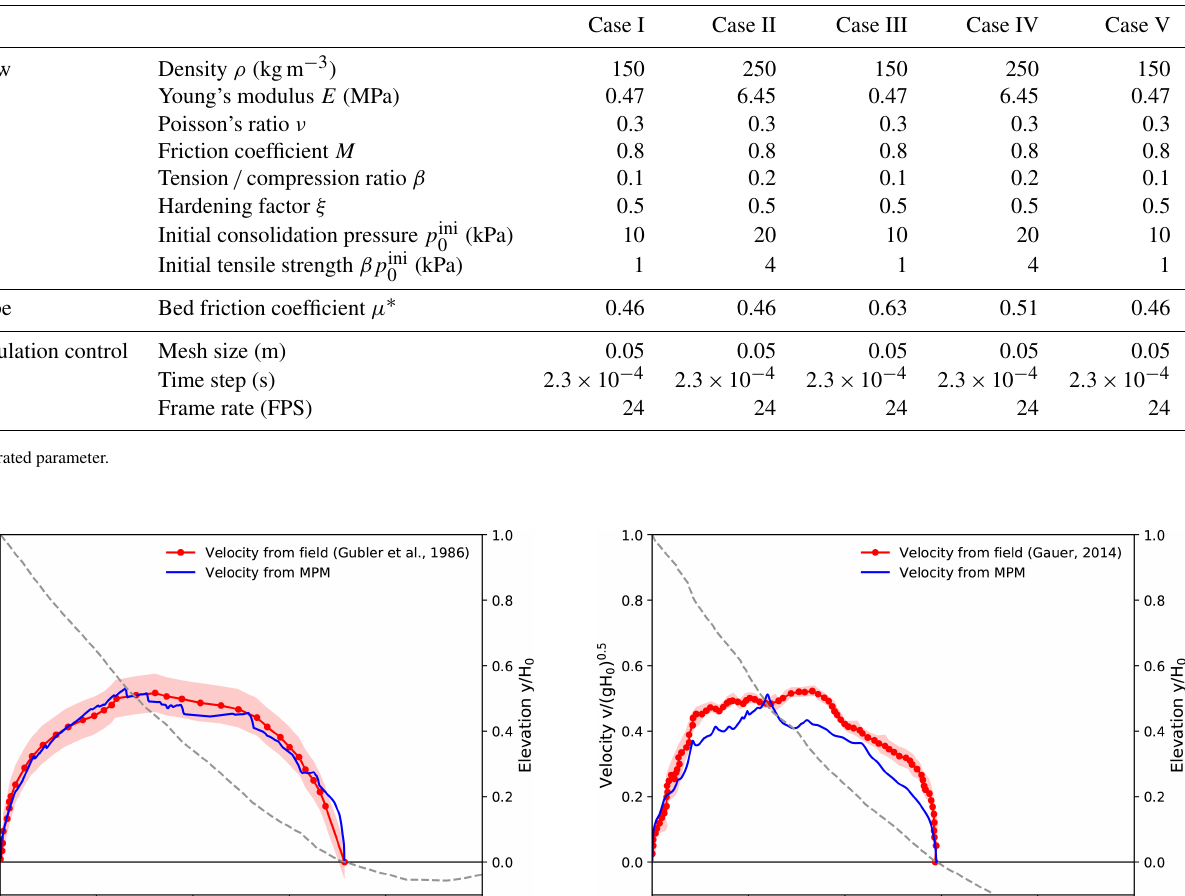
Table 3. Adopted parameters in the five MPM simulations of snow avalanches on real terrains.